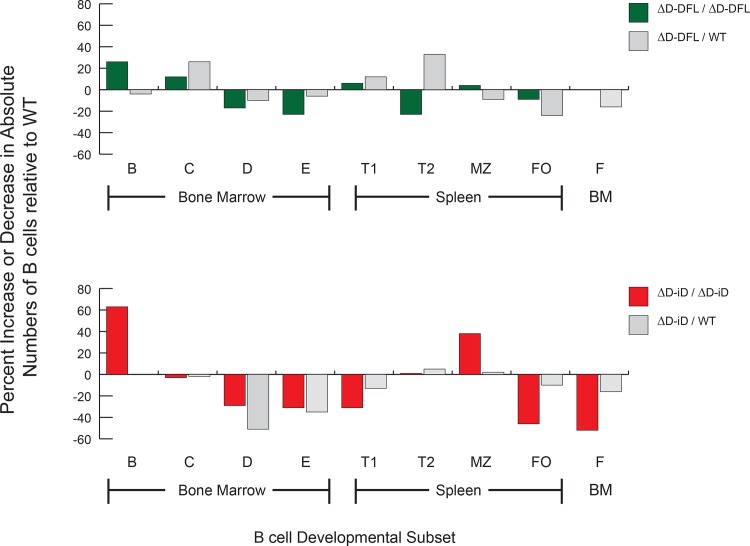
Divergence in the absolute numbers of B lineage subpopulations from the bone marrow, spleen, and peritoneal cavity of homo- and heterozygous ΔD-DFL and ΔD-iD mice relative to their littermate controls.Percent loss or gain in homo- and heterozygous ΔD-DFL
(top) and ΔD-iD (bottom) mice relative to wild type littermate controls in the average absolute number of cells in bone marrow fractions B (CD19+ CD43+ HSA+ BP-1-), C (CD19+ CD43+ HSA+ BP-1+), D (CD19+ CD43- IgM- IgD-), E (CD19+ CD43- IgM+ IgD-), and F (CD19+ CD43- IgMlo IgDhi); and in splenic transitional T1 (CD19+ AA4.1+ sIgMhi CD23-), T2 (CD19+ AA4.1+ sIgMhi CD23+), marginal zone (MZ, CD19+ CD21hi CD23lo), and mature (M, CD19+ CD21lo CD23hi) B-cell subsets. The distribution of B cell numbers by subset in homozygous ΔD-DFL and ΔD-iD mice has been previously published [31,32] and is included for clarity. The standard error of the mean of each B lineage subpopulation for the littermate controls averaged approximately 11% of the absolute number of cells in each subpopulation. For ΔD-DFL and ΔD-iD, the standard error of the mean is shown as an error bar. ‘*’, p ≤ 0.05 and ‘****’, p < 0.0001.